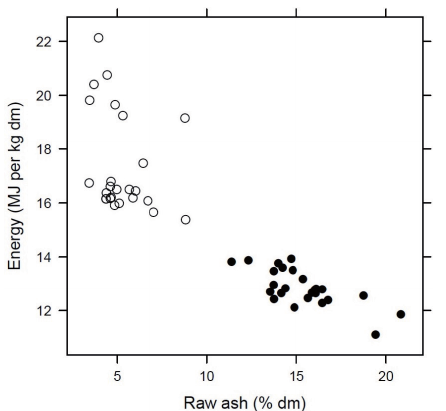
Fig. 5: Dependence of calorific values on raw ash contents of 25 randomly selected plants each of S. hermaphrodita accession number 3 ( ○ ) and S. perfoliatum accession number 8 ( ● ) that were harvested when plants had completely senesced, i.e. 263 and 279 DAS,